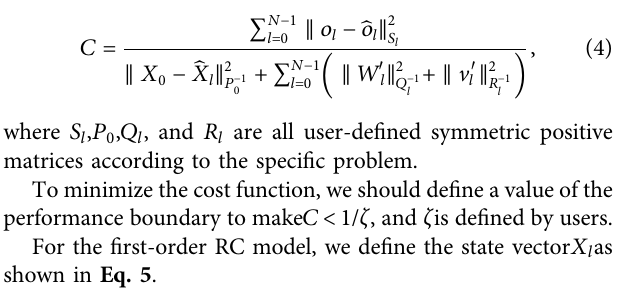
Frontiers in Energy Research |